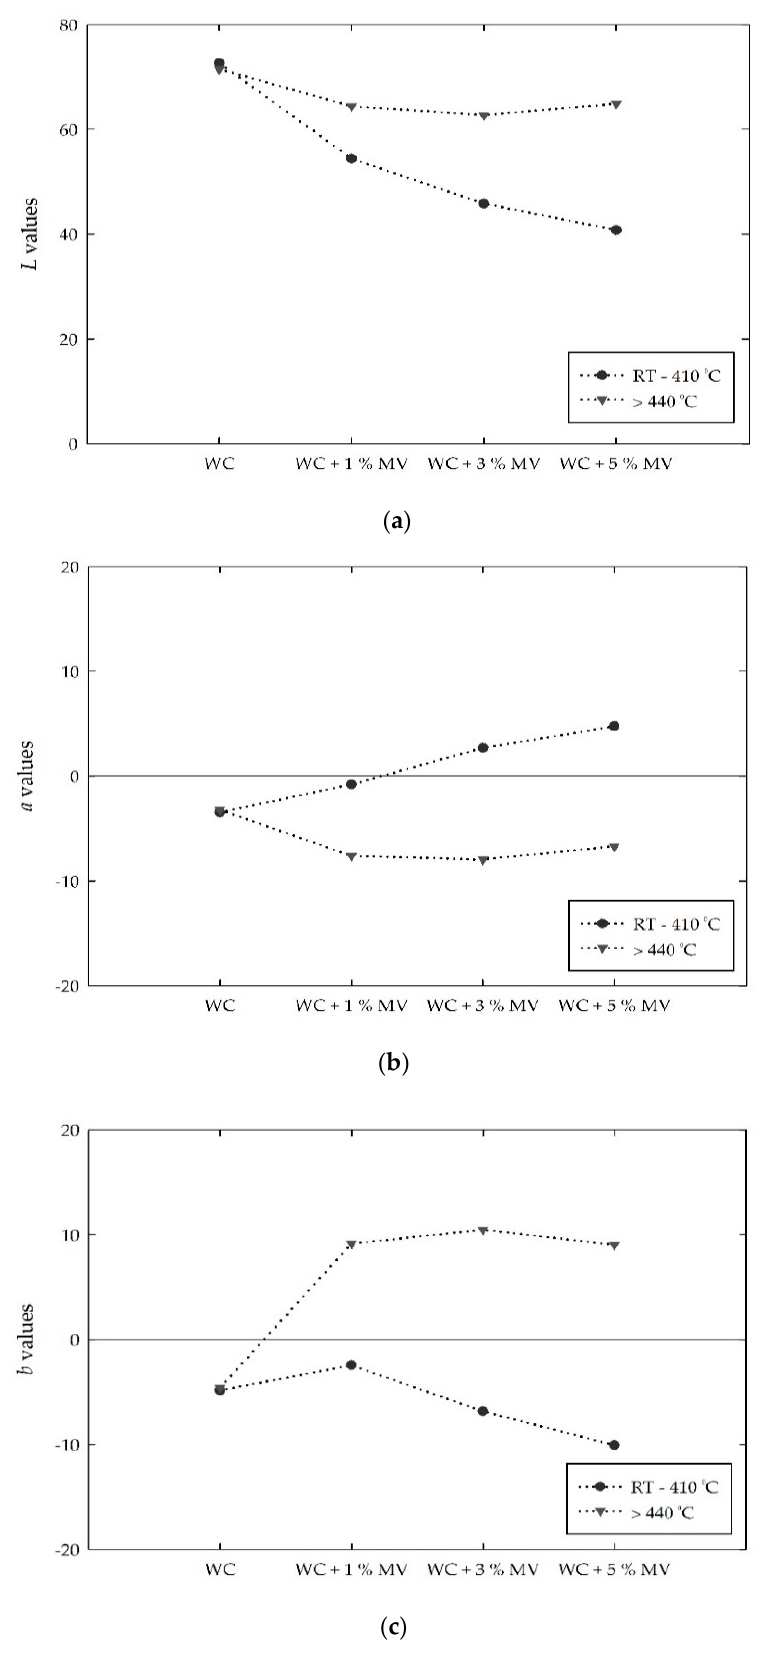
Figure 14. Comparisons of the Lab values for the white cement (WC) mixed samples with increasing temperature: ( a ) L values; ( b ) a values; and ( c ) b values.